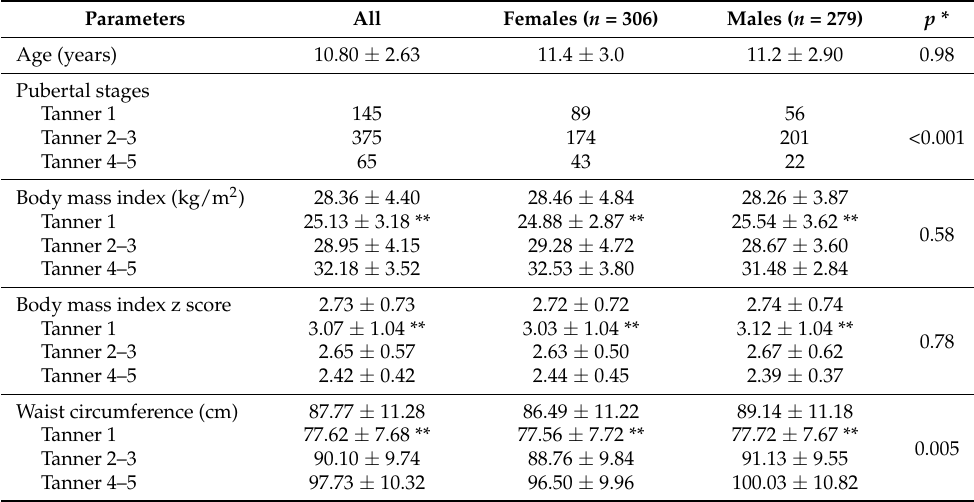
Table 1. Indexes of obesity and insulin resistance and metabolic parameters of the patients according to sex and pubertal